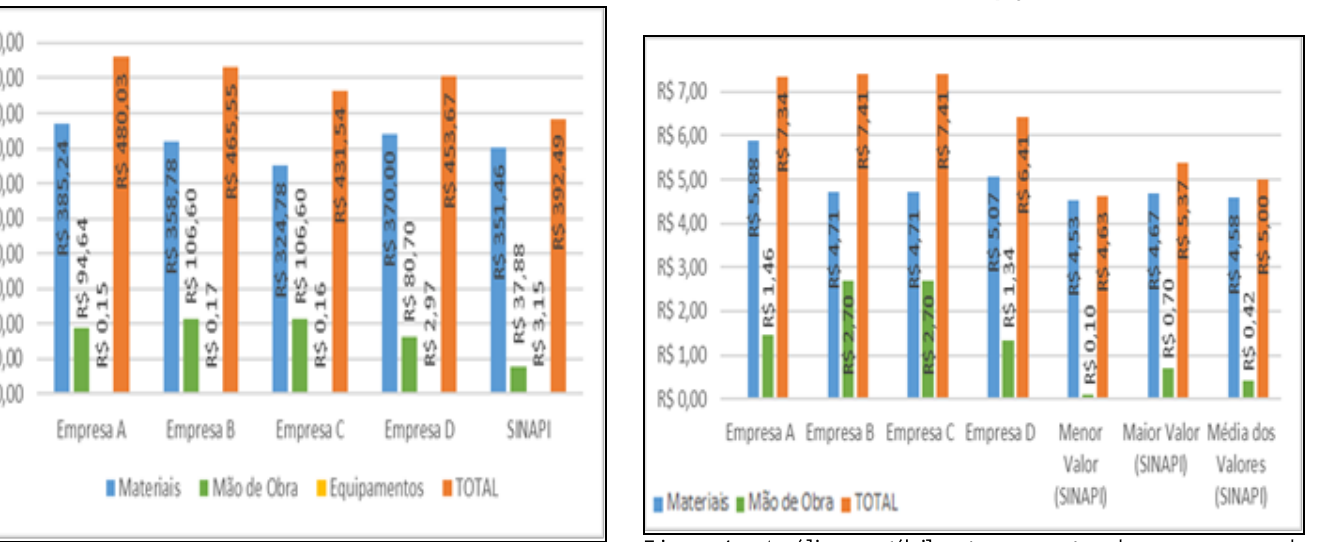
Figura 3: Análise contábil entre os custos das empresas e do SINAPI (Produção de Concreto).